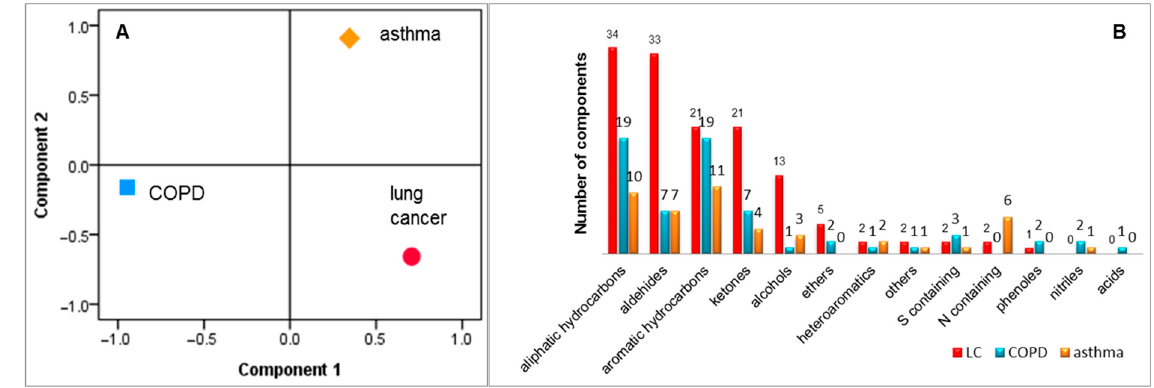
Figure 4. Discrimination between asthma, COPD and lung cancer, based on emitted VOCs (part ( A )) and classification of collected volatiles according with chemical classes (part ( B )).